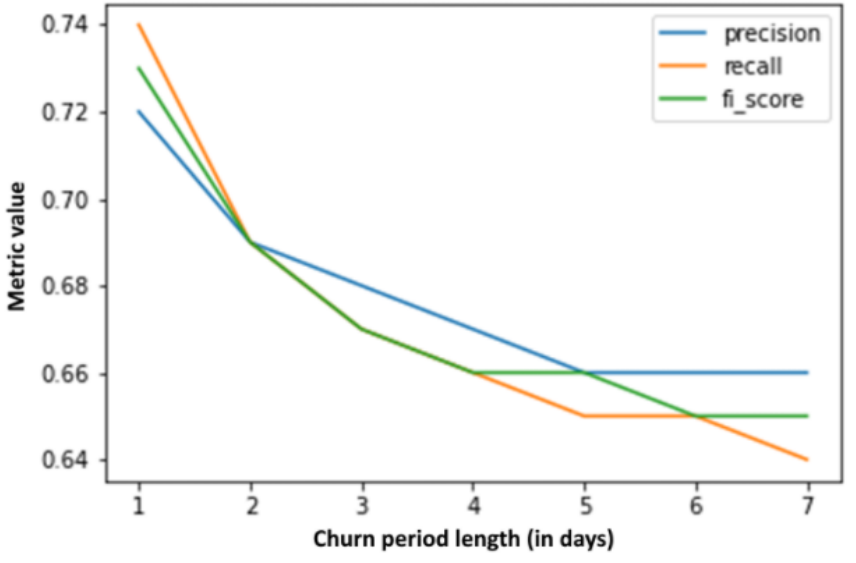
Figure 11. Metric changes by churn period